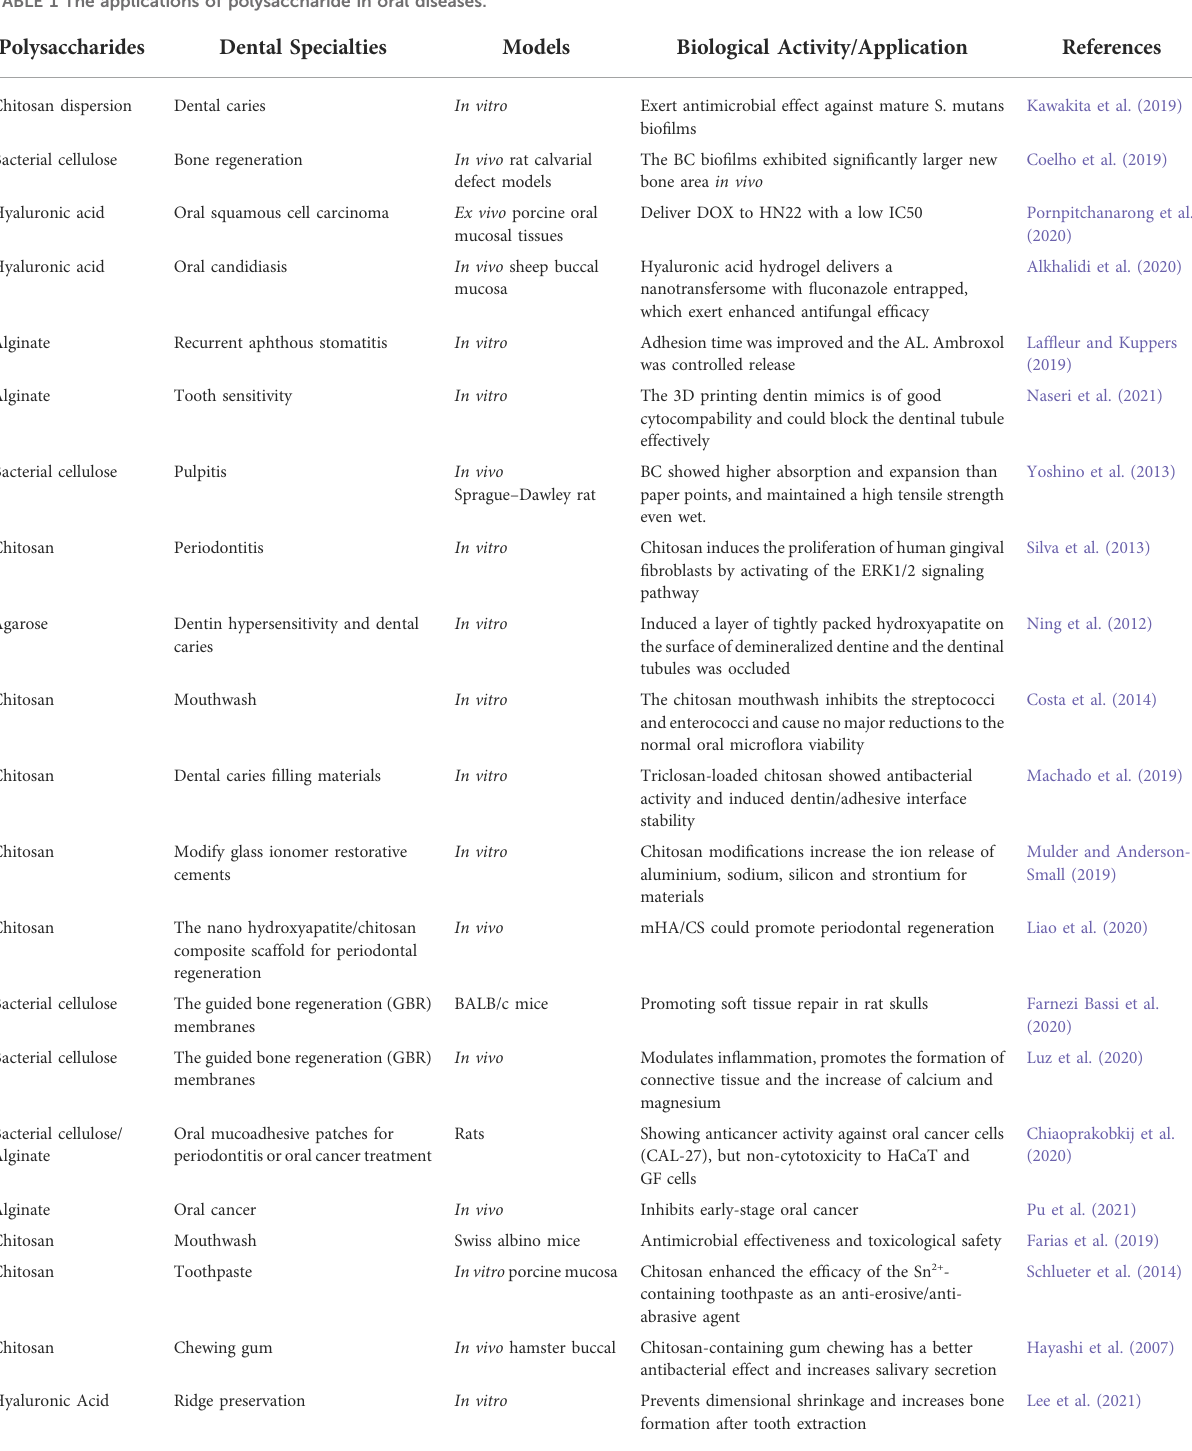
TABLE 1 The applications of polysaccharide in oral